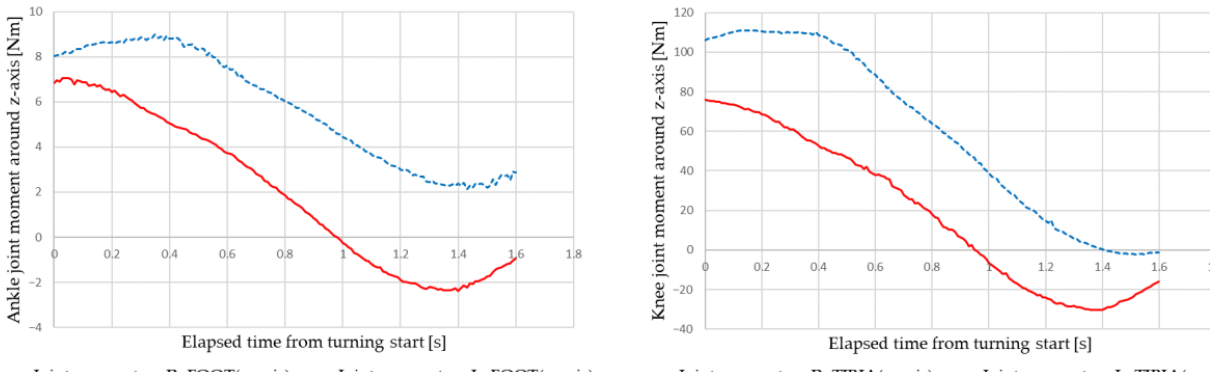
Figure 21. Ankle and knee joint moments during manual turning.